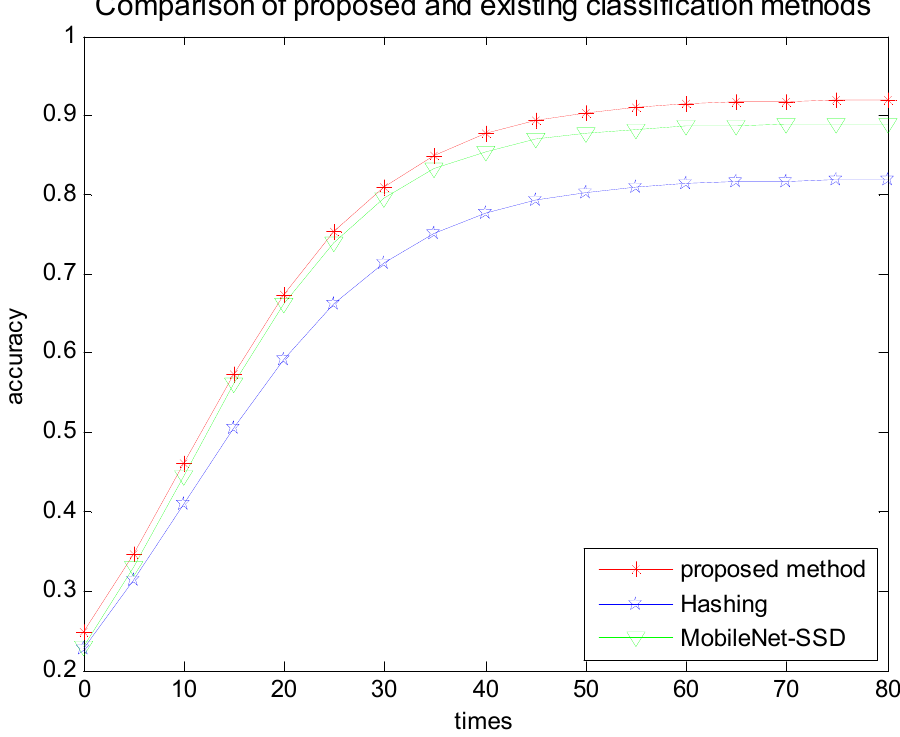
Figure 7. Comparison of proposed and existing classi fi cation methods.